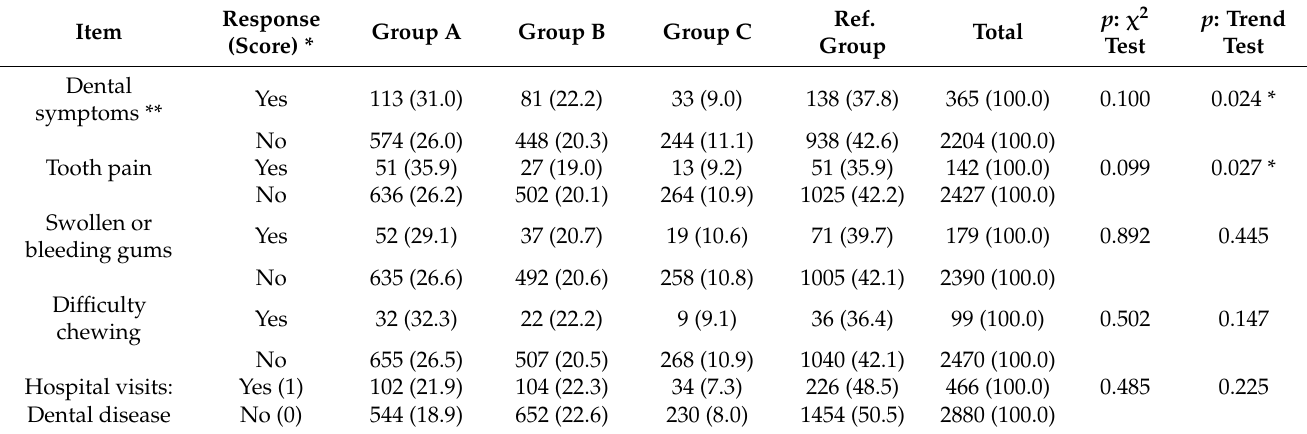
Table 5. Comparison of subjective dental symptoms and hospital visits by sleep